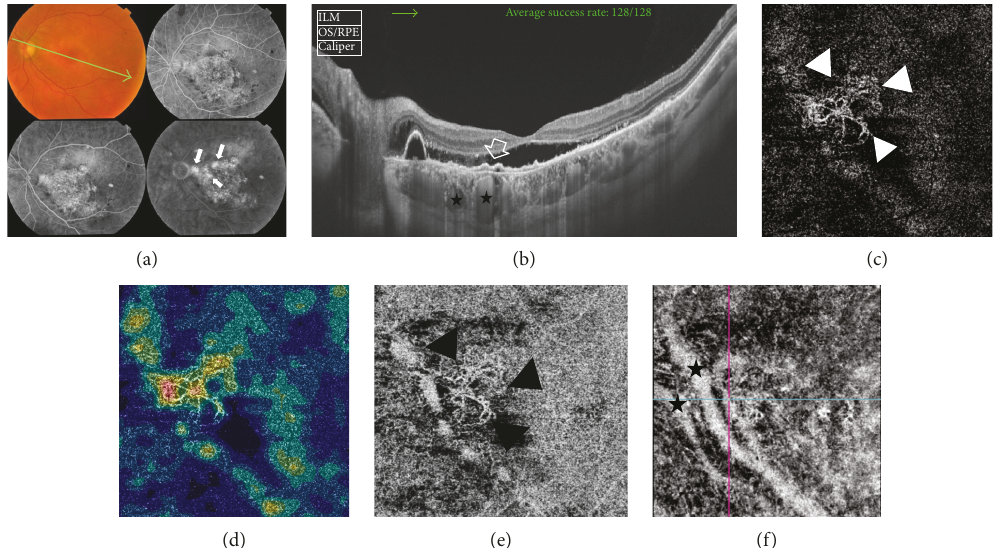
Figure 2: (a) The colored photo and FFA of the left eye of a 46-year-old male with bilateral chronic CSCR of approximately 1.5-year duration. The posterior pole shows di ff use retinal pigment epitheliopathy in the macular area measuring approximately 5 disc diameters (DD) in size along with shallow subretinal fl uid and peripapillary PED. FFA shows a large hyper fl uorescent area caused by window defect that corresponds to the area of retinal pigment epitheliopathy seen in the colored photo. In addition, the macular area shows multiple hyper fl uorescent leaking points that gradually increase in intensity throughout later phases with a typical inkblot pattern of leakage (arrows). (b) SS-OCT image. A 12.0mm radial scan is selected to include the peripapillary area. The scan shows subfoveal neurosensory detachment extending to the peripapillary area, which is associated with subretinal deposits. A single large regular smooth PED is seen in the peripapillary area. A subfoveal shallow PED with an undulating thickened surface and sub-RPE hyperre fl ective amorphous deposits is shown (open arrow). The subfoveal choroidal vessels are engorged (black stars). Subfoveal choroid thickness is 455 μ . (c) The en face SS-OCTA image of the same eye taken at the level of the outer retina in a 4.5mm × 4.5mm fi eld. Note the hyperintense signal caused by increased blood fl ow within the CNV complex. The complex is composed of a network of tiny arborizing capillaries with frequent anastomosis and looping in the periphery of the lesion (white arrow heads). (d) The corresponding color-coded density map re fl ecting blood fl ow at the level of the outer retina. Note the entire background has variable shades of blue typical of avascular outer retina. The CNV complex stands out with its bright red signal indicating dense blood fl ow. (e) The en face SS-OCTA image of the same lesion at the level of the choriocapillaris (black arrow heads). (f) The en face SS-OCTA image after manual adjustment of the segmentation slab to a deeper position into the choroid to demonstrate two abnormally dilated choroidal vessels corresponding to increased subfoveal choroidal thickness on SS-OCT (black stars).